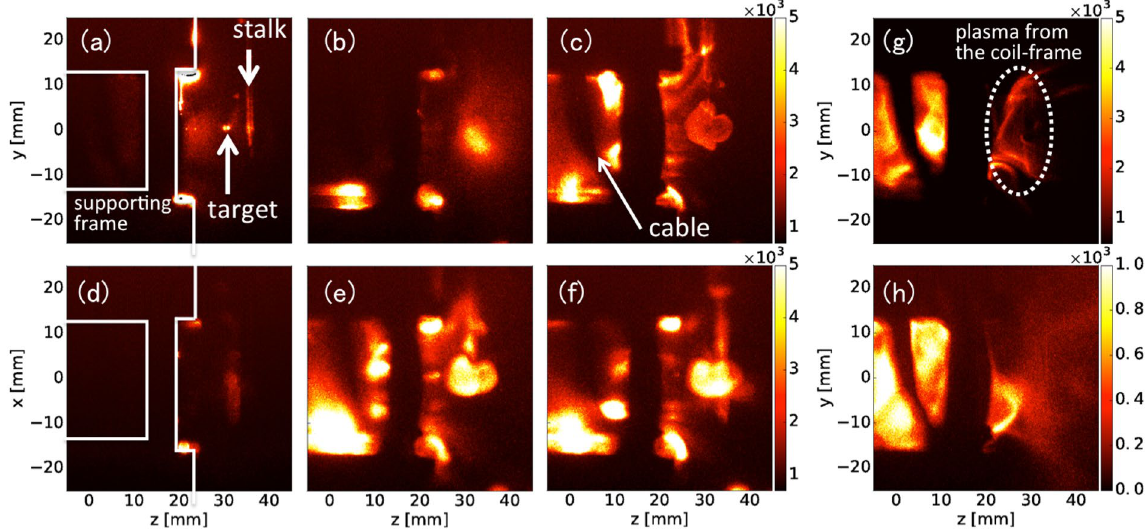
Figure 3. Self-emission at t = 0.1 μ s [( a ) and ( d )], 0.2 μ s [( b ) and ( e )], and 0.5 μ s [( c ) and ( f )]. Upper and lower panels show, respectively, the data obtained from four-coil and three-coil operations. White lines show the surface of a supporting frame of the coil. The data ( g ) and ( h ) are the emissions at 2 μ s and 5 μ s, respectively, with four coils.